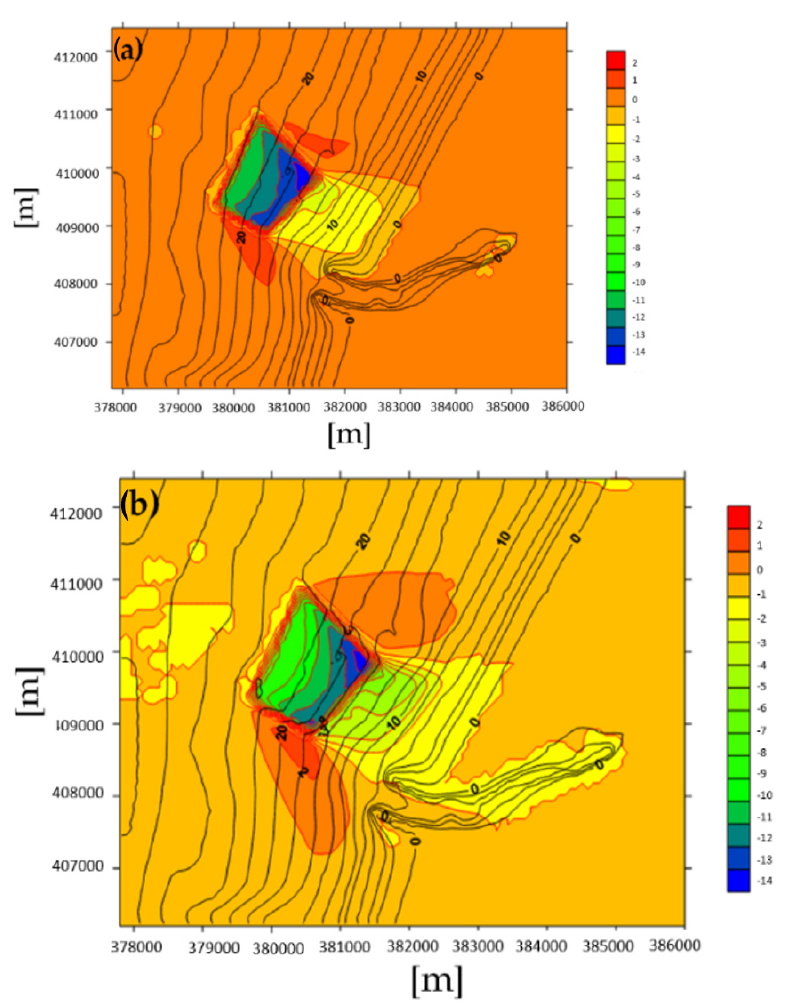
Figure 9. Relative bottom friction velocity, ( a ) ( H s0 = 1.5 m, T p = 8 s), ( b ) ( H s0 = 4 m, T p = 12 s) after dredging of 2 m depth. The legend indicates the values of relative friction velocity in [cm/s]. The contour lines indicate the bathymetry values.